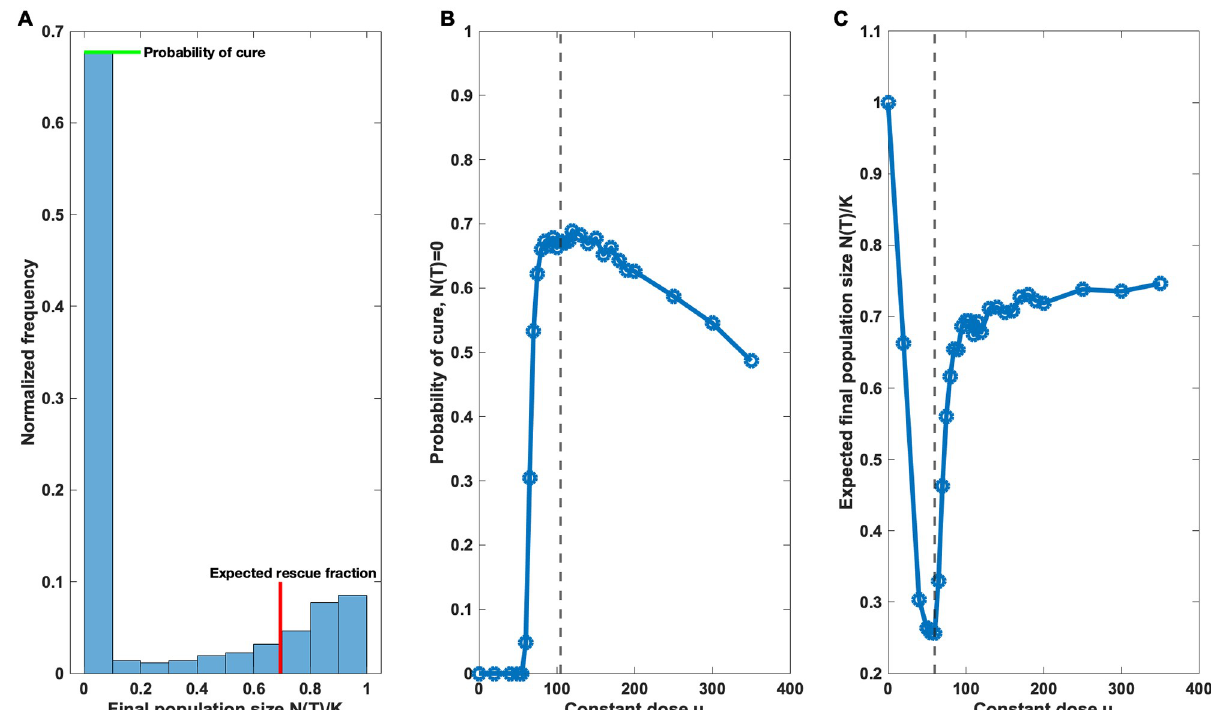
Fig 4. Non-monotonic dose responses. n sim = 2000 constant therapies were simulated for each dose while recording the final population sizes N ( T ). A Example of a bimodal distribution of the normalized final population sizes N ( T )/ K using the optimal constant dose u = 104.5 that minimises the rescue probability (cost function Eq (3)). The zero mode corresponds to the proportion of extinct populations (cure) and the second mode corresponds to the expected size of the rescued population. Each dose leads to its own characteristic bimodal distribution. B The proportion of extinct populations N ( T ) = 0 plotted as a function of dose. The probability of cure displays non-monotonicity and is maximised in the neighborhood of the optimal dose u = 104.5 (dashed line), which was determined analytically using the stationary Eq (5). C The mean final population sizes of the rescued populations N ( T )/ K plotted as a function of dose (the extinct populations were excluded). The expected rescue size is minimised at u = 60 (dashed line), which agrees to the numerical solution S3 Fig of the discounted problem Eq (4).